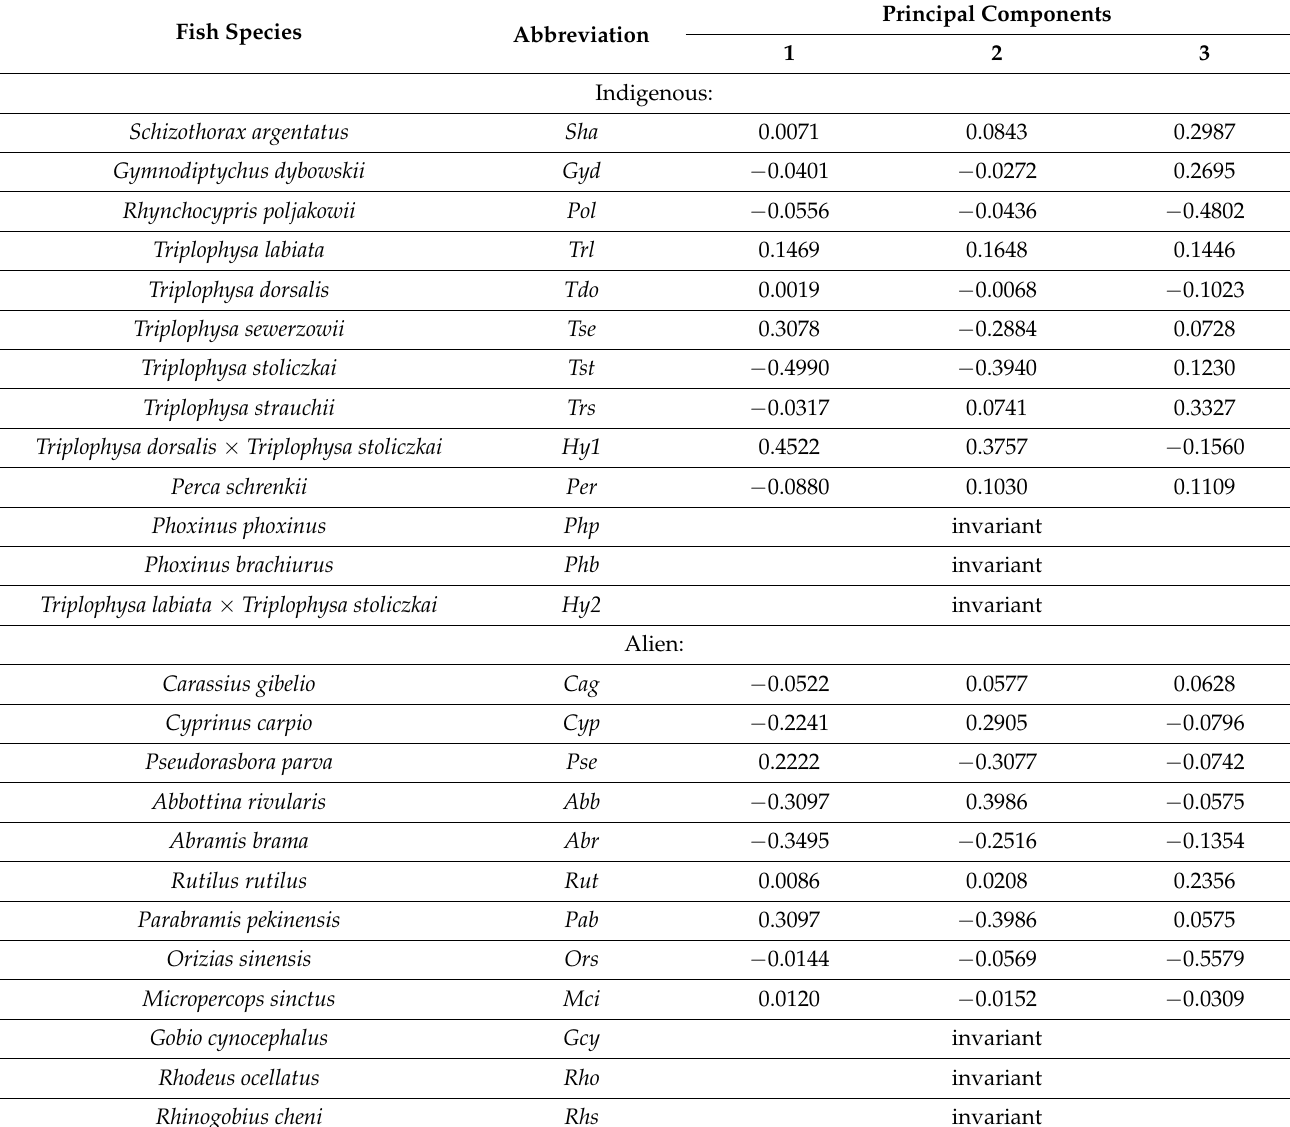
Table 4. Principle component factor loadings for the